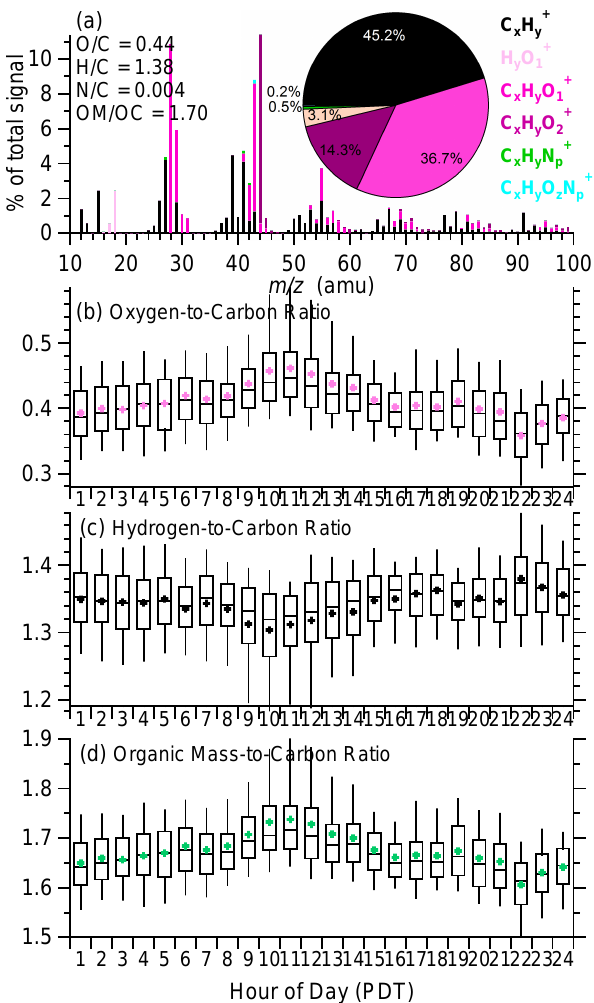
Fig. 10. (a) Average high resolution mass spectrum of organics colored by ion category, along with a pie chart with the contribu- tion of each ion category to the total signal. Diurnal patterns of (b) oxygen-to-carbon (O/C) ratio, (c) hydrogen-to-carbon (H/C) ra- tio, and (d) organic mass-to-carbon (OM/OC) ratio of organics. The C x H y S n O + z family is not shown in the pie chart due to its very small contribution (average = 0.09%). Box plots: whiskers correspond to the 10th and 90th percentile, boxes to the 25th and 75th percentile, the horizontal marks in the boxes to the median, and the colored crosses to the